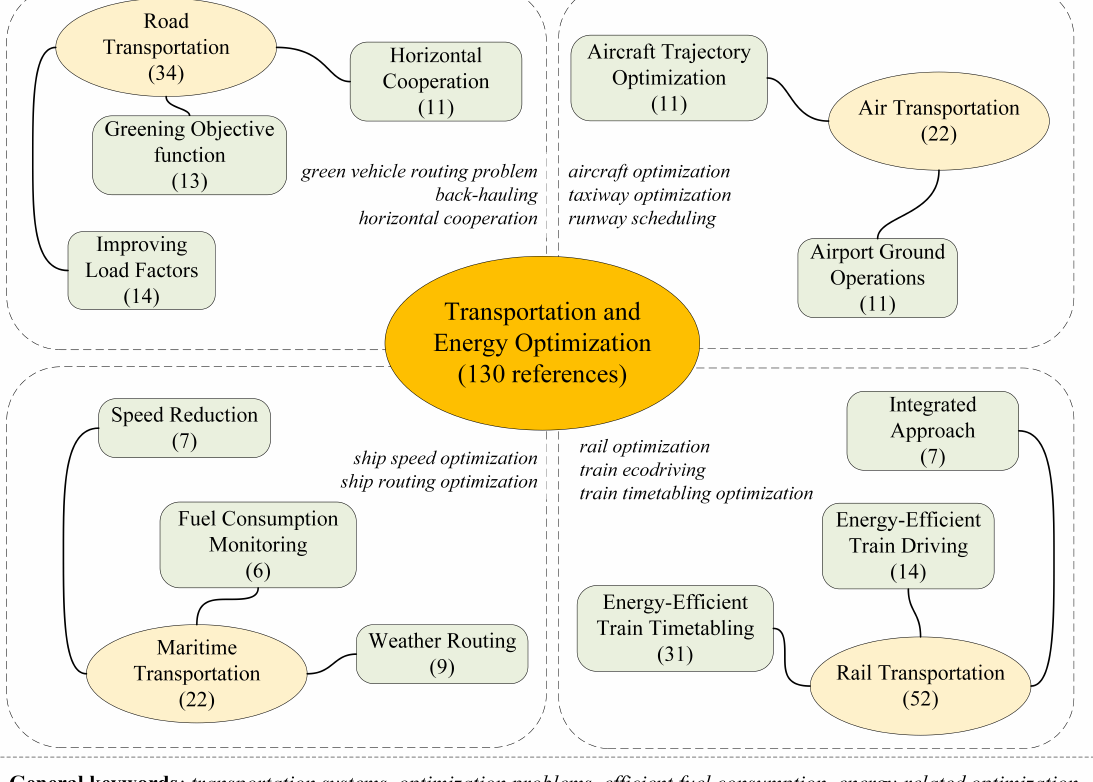
Figure 1. Overview of the literature with keywords and references